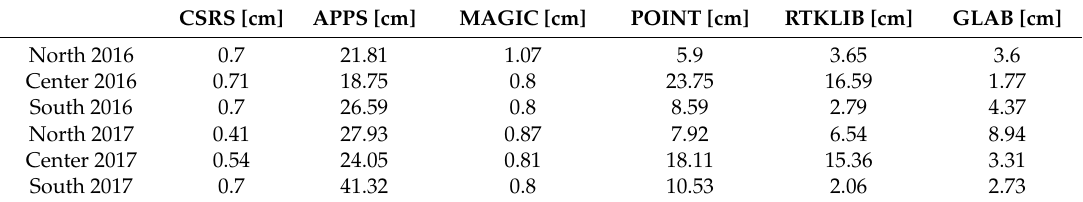
Table 6. RMSE values in centimeters by groups in October 26th 2016 and